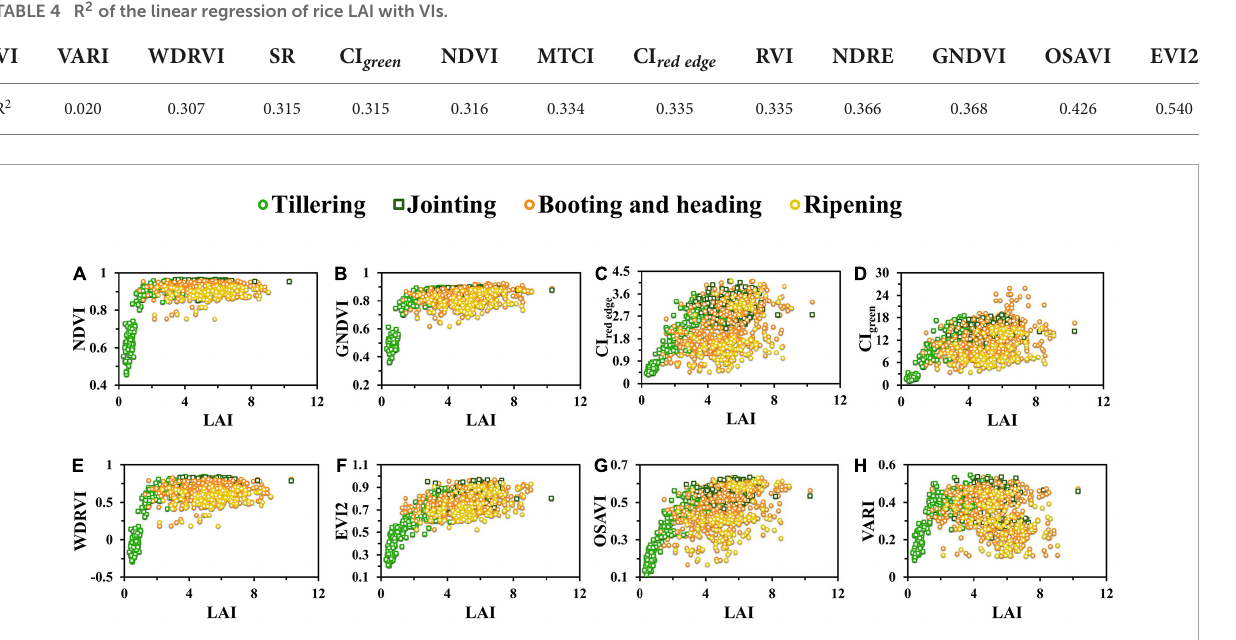
Among all tested VIs, EVI2 and OSAVI held the highest R 2 values of 0.426 and 0.540 ( Table 4 ), respectively. The scattered ratio indices (CI red edge and CI green ) ( Figures 4C,D ) and